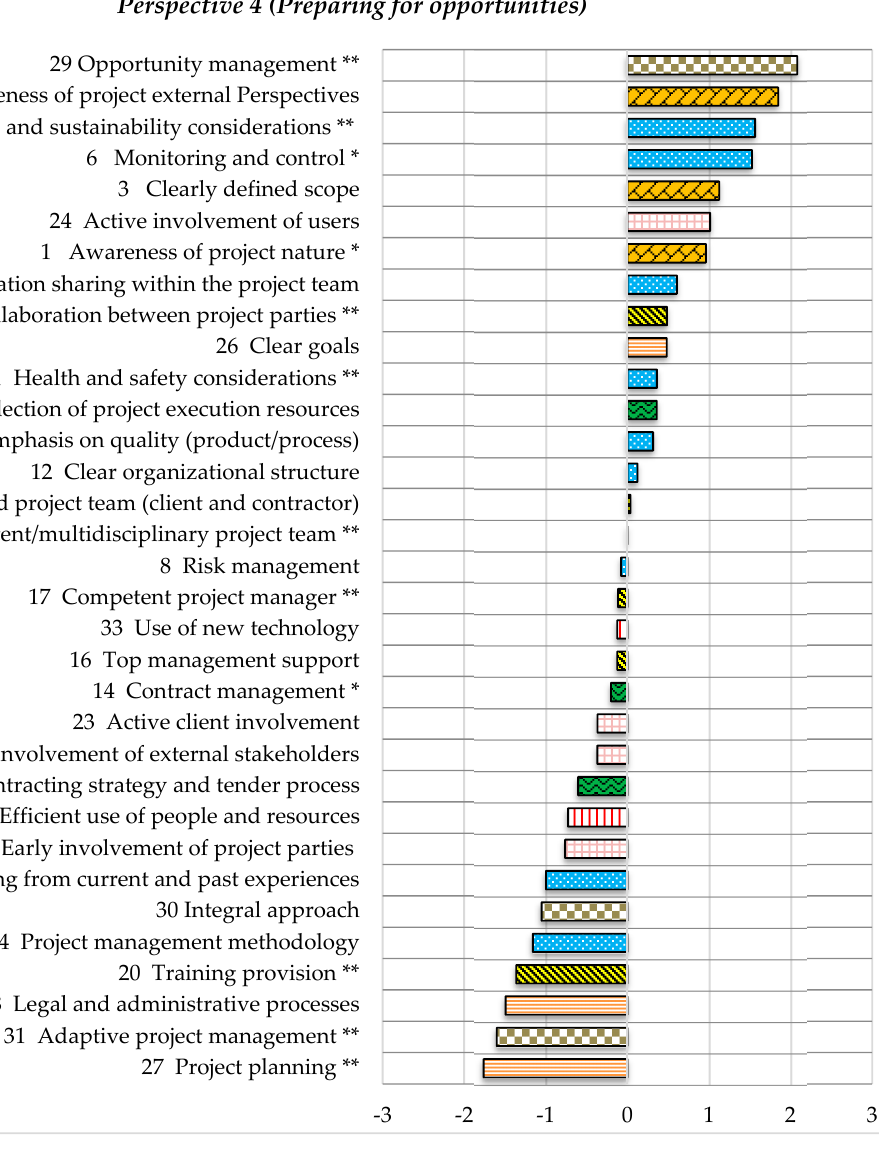
Figure 5. Ranking of success factors for the preparing for opportunities perspective (P4). “*” The factor is distinguishing at p < 0.05; “**” The factor is distinguishing at p < 0.01.